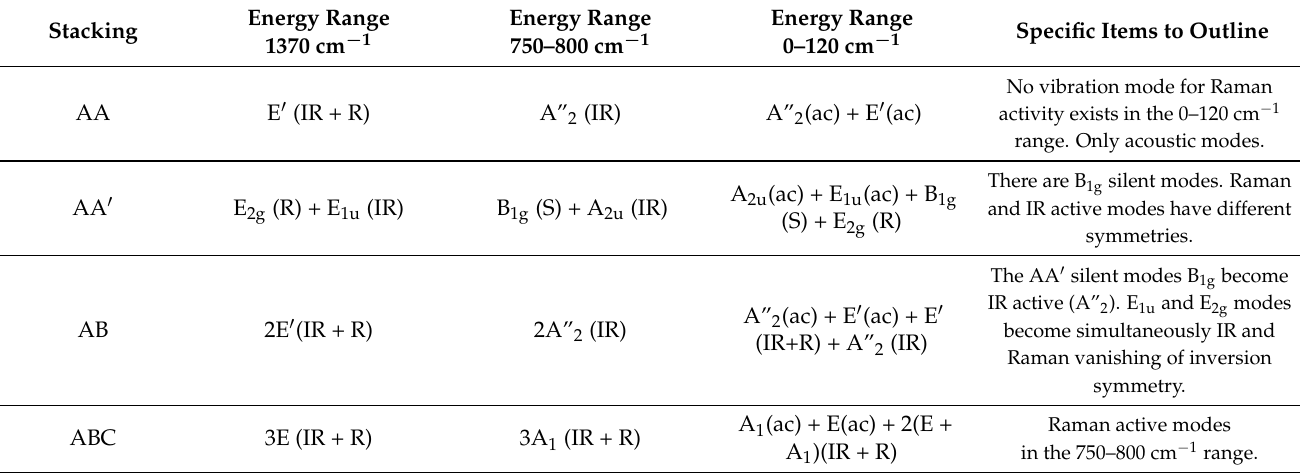
Figure 5. Dispersion of the phonons along Γ − K for the AA ( a ), AA’ ( b ) and ABC ( c ) stackings of boron nitride. The green dotted line in ( a ) shows a mode which is absent in the AA stacking. The magenta curve in ( c ) stands for the additional Raman mode in the 750–800 cm − 1 range. Table 2. Phonon modes specifications of four BN